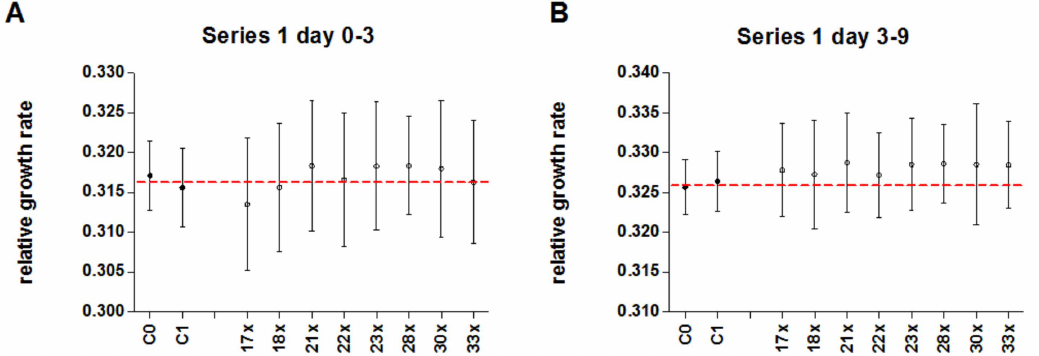
Figure 6. Mean relative growth rate ( ± 95% CI) of duckweed treated with either potentised As 2 O 3 (potency levels 17x–18x, 21x–23x, 28x, 30x, 33x, numerically pooled, n = 25 each) or water as control (unsuccussed and succussed water samples, numerically pooled, n = 85 each) in the 5 independent experiments of series 1. ( A ) Early time period (day 0–3), ( B ) Late time period (day 3–9). The red line represents the mean of water controls. Table 3. Statistical analysis of experimental series 1. Results of two-way ANOVA of series 1 for numerically pooled treatment (As 2 O 3 17x–18x, 21x–23x, 28x, 30x, and 33x) and numerically pooled control (unsuccussed and succussed water) groups for n = 5 independent experiments in the